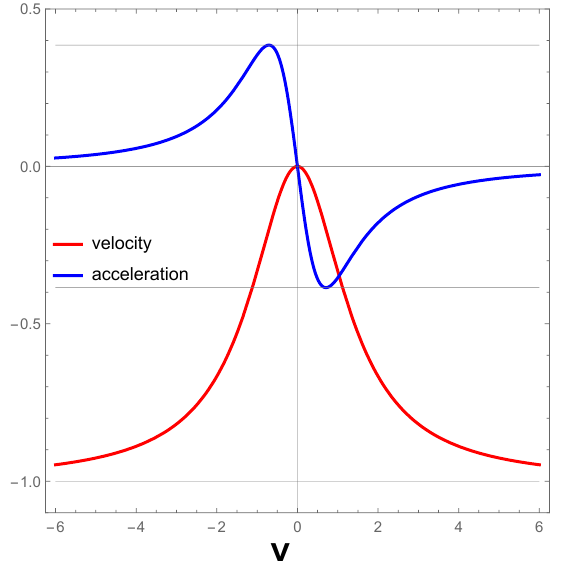
Figure 3. The velocity and proper acceleration as a function of light-cone coordinate advanced time v = t + x for the mirror trajectory, Equation (3). At v = 0, the velocity V = 0, but asymptotically | V | → 1 and the proper acceleration vanishes, α → 0. The maximum acceleration occurs at | α max | = √ 2 κ / ( 3 3 ) = 0.385 κ . Here v is in units of 1/ κ and the maximum accelerations happen at advanced √ time κ vs . = ± 1/ 2 =